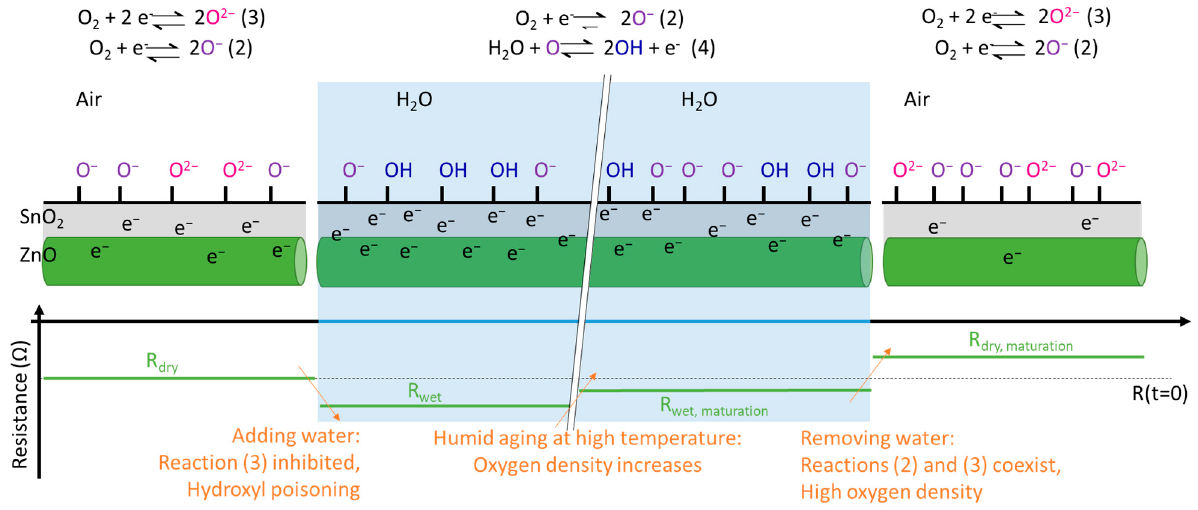
Figure 4. Schematic representation of phenomenon occurring during the experimental sequence, taking account of the water-oxygen interplay as described in Section 2. Detailed explanations are given in the text Section 4.3. This diagram is an adaption from Suematsu et al. [25].